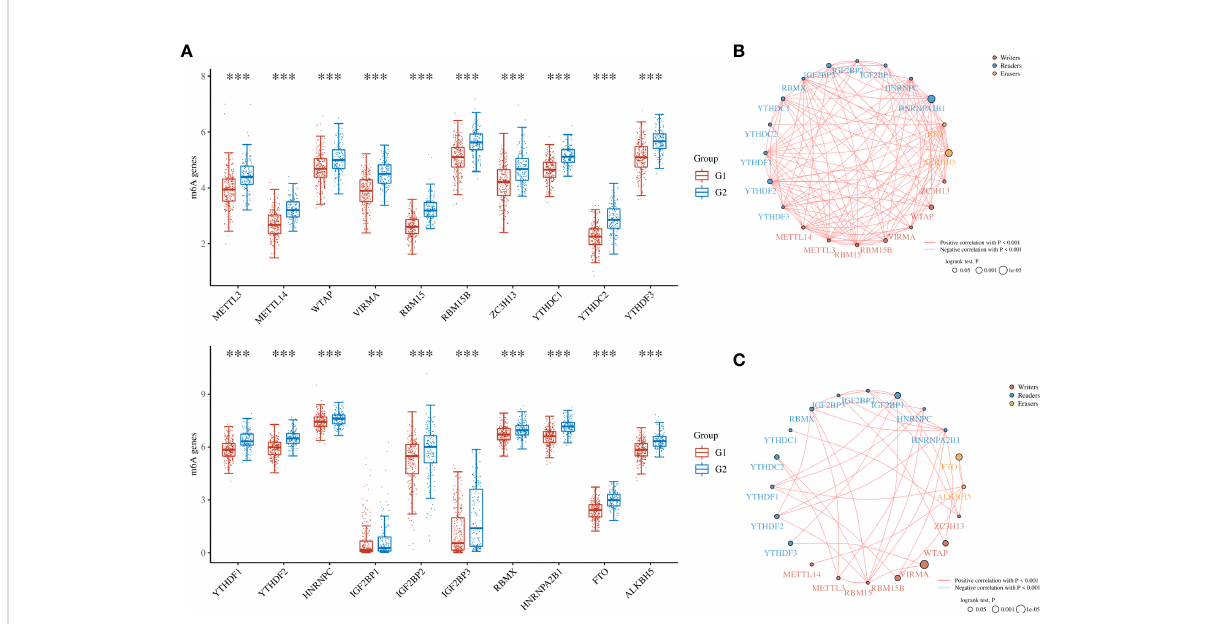
FIGURE 7 The m6A levels in different subgroups of OSC. (A) Heatmap of m6A-related genes in Cluster 1 and Cluster 2. (B) The network construction of m6A-related genes in Cluster 1 samples. (C) The network construction of m6A-related genes in Cluster 2 samples. (G1 is the group of the Cluster 1 for OC patients. G2 is the group of the Cluster 2 for OC patients.) **p < 0.01; ***p <